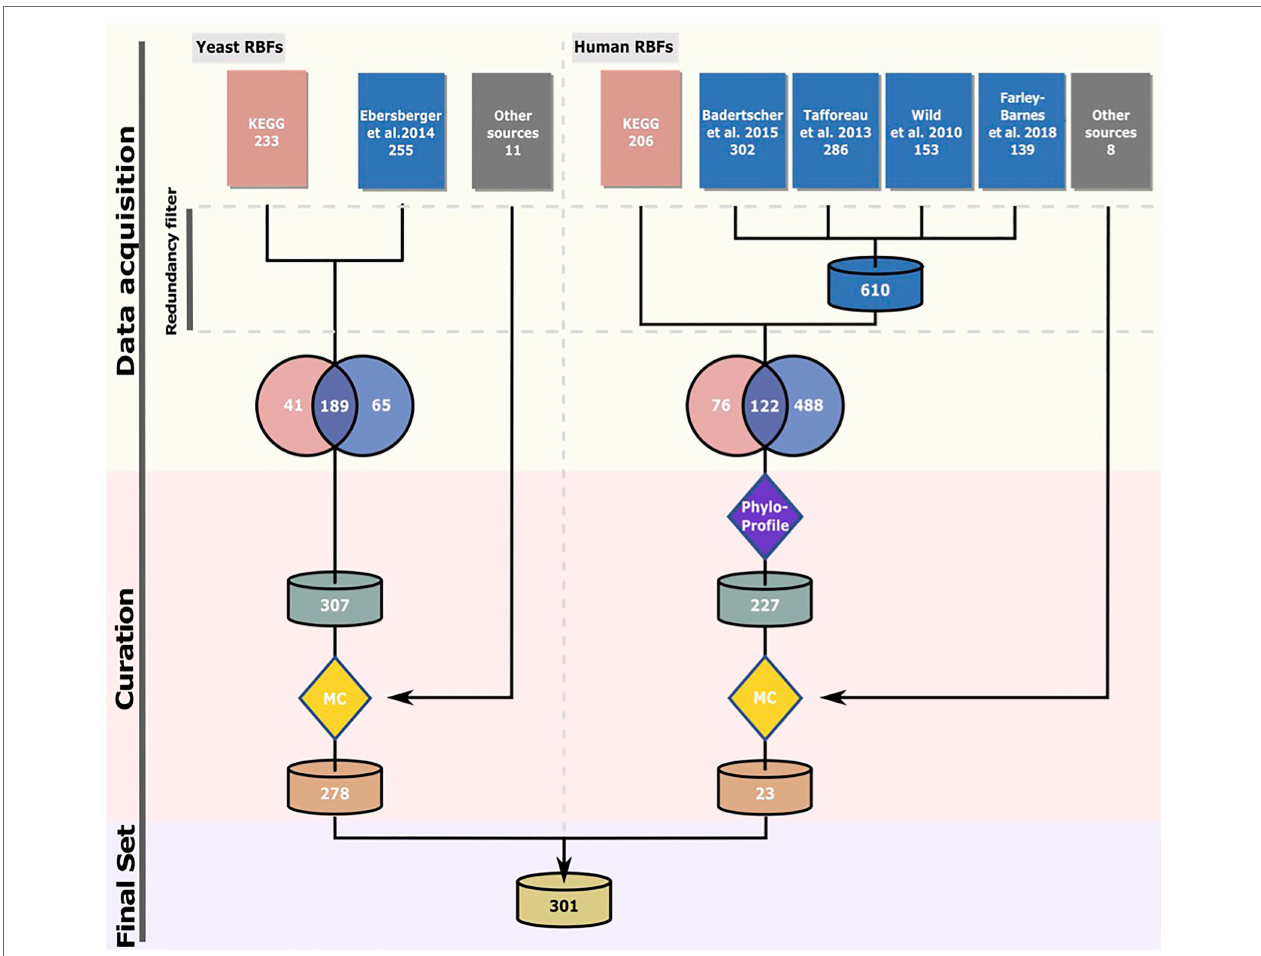
FIGURE 1 | Compilation of the RBF set. The “Phylostratigraphy” filter removed proteins younger than last eukaryotic common ancestor (LECA) and proteins with an ortholog in yeast. In the manual curation (MC) step, only proteins for which experimental evidence supports their association with pre-ribosomal particles or requirement for ribosome assembly were retained. See text for details. The sources for the candidate proteins are specified in Supplementary Table S1 (yeast) and Supplementary Table S2